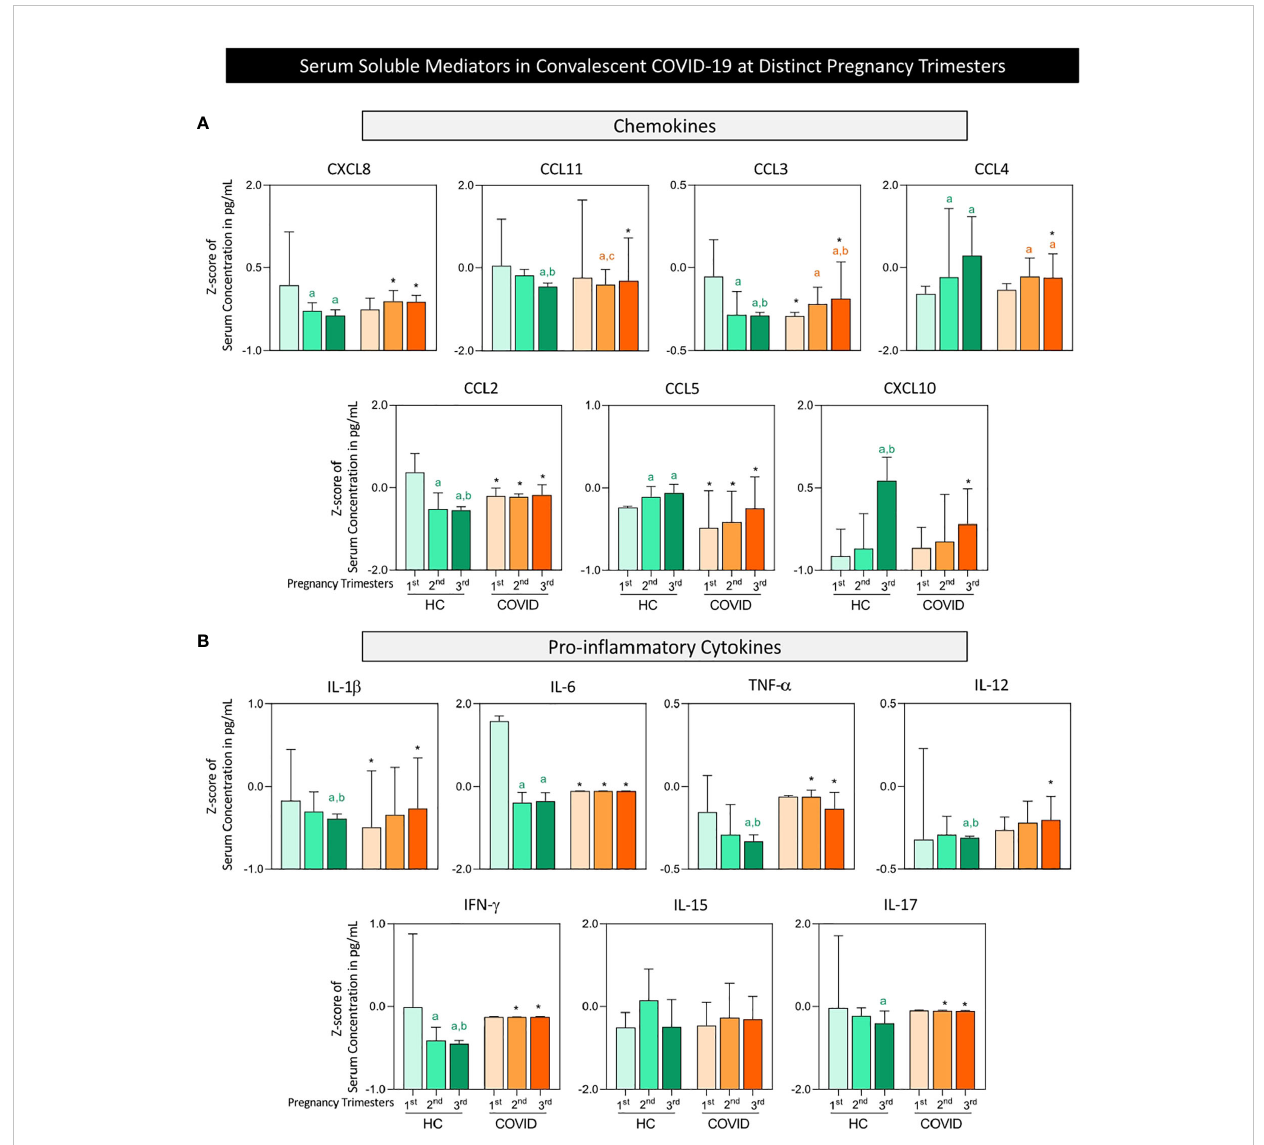
FIGURE 1 Serum and pro-in fl ammatory cytokines in convalescent COVID-19 patients at distinct pregnancy trimesters. The levels of: (A) chemokines (CXCL8, CCL11, CCL3, CCL4, CCL2, CCL5, CXCL10), and (B) pro-in fl ammatory cytokines (IL-1 b , IL-6, TNF- a , IL-12, IFN- g , IL-15, IL -17) were measured in serum samples from pregnant women with convalescent COVID-19 at 3-20 weeks after symptoms onset (COVID, n=89), with pre-pandemic non- infected pregnant women as a Healthy Control (HC, n=52). The HC and COVID-19 groups were further categorized into subgroups according to pregnancy trimester, referred to as: HC 1 st ( , n=21), HC 2 nd ( , n=10), HC 3 rd ( , n=21), and COVID 1 st ( , n=7), COVID 2 nd ( , n=34), COVID 3 rd ( , n=48). The measurements were taken by high-throughput multiplex bead array as described in Material and Methods. The results are presented in bar charts of median values and interquartile ranges for Z-score of serum concentration (pg/mL). Multiple comparative analysis was performed by Kruskal-Wallis followed by Dunn ’ s post-test and comparisons between COVID-19 and HC at matching pregnancy trimesters assessed using the Mann-Whitney test. In all cases, signi fi cance was considered at p<0.05. Intragroup differences were underscored by the letters “ a ” , “ b ” and “ c ” for comparisons with the 1 st , 2 nd and 3 rd trimesters, respectively. Inter-group differences at matching pregnancy trimesters were highlighted denoted by an asterisk